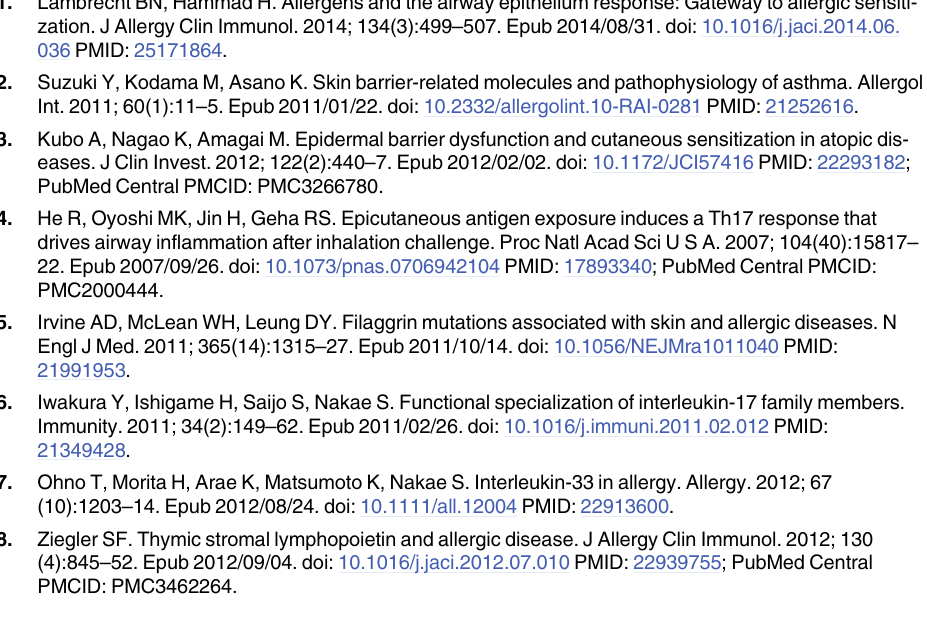
S15 Table. Individual data depicted in Fig 6C. S16 Table. Individual data depicted in Fig